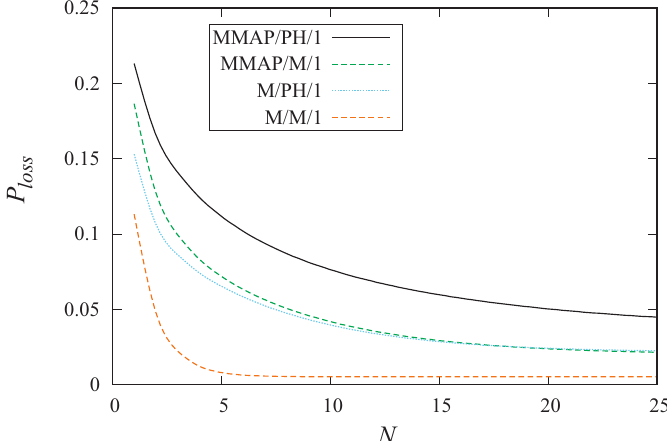
Figure 7. The dependence of the probability P loss on the buffer capacity N for the considered set of the system